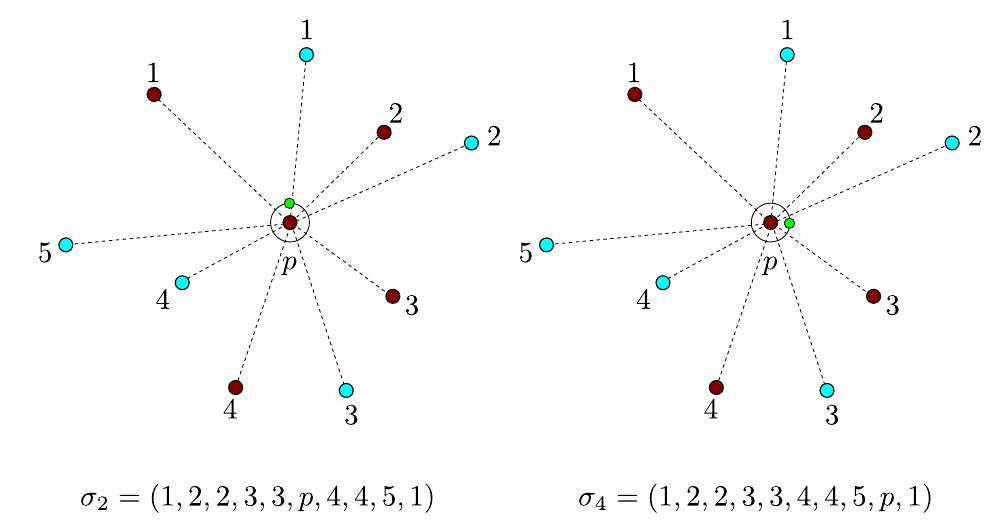
Fig. 6: A walk showing a linear lower bound on the number of colored radial